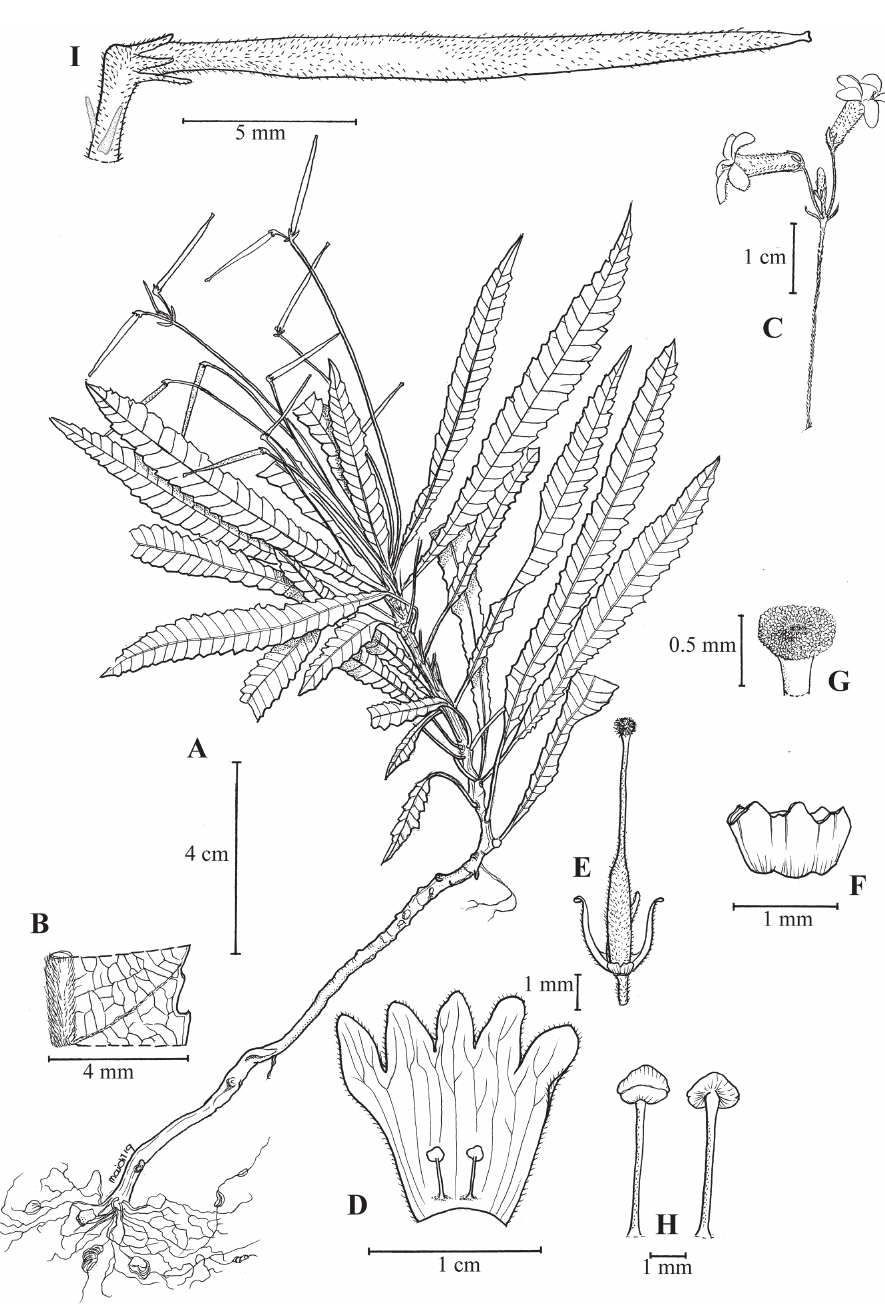
Figure 1. Illustration of Codonoboea kenaboiensis Syahida-Emiza, Y.Y.Sam & Siti-Munirah, sp. nov. A habit B leaf section show midrib and reticulate vein C inflorescence D flower opened to show position of stamens e calyx with pistil F nectary annular G stigma h stamens I fruit (All from FRI 87630 , drawn by Mohamad Aidil